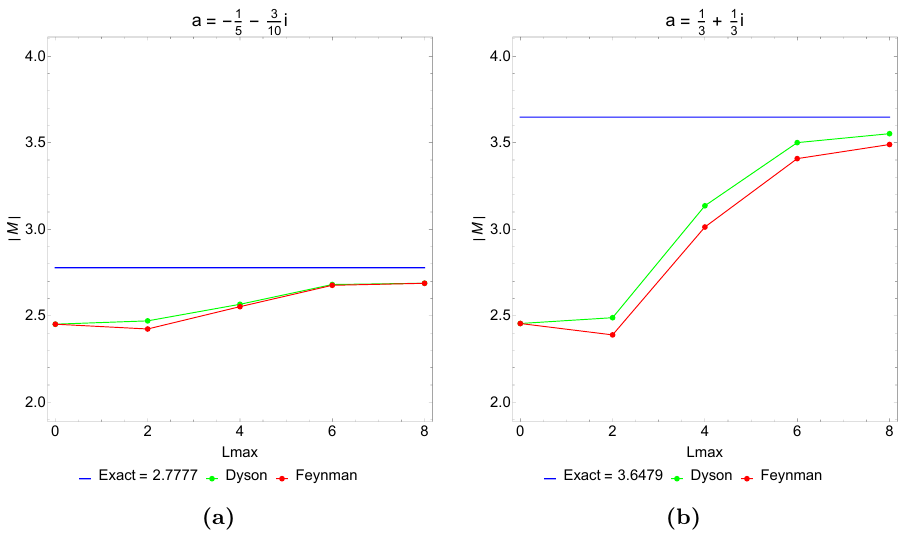
Figure 6. Numerical illustrations using pion amplitude in [51, 52]. Dyson block and Feynman block expansion of amplitude. We consider s